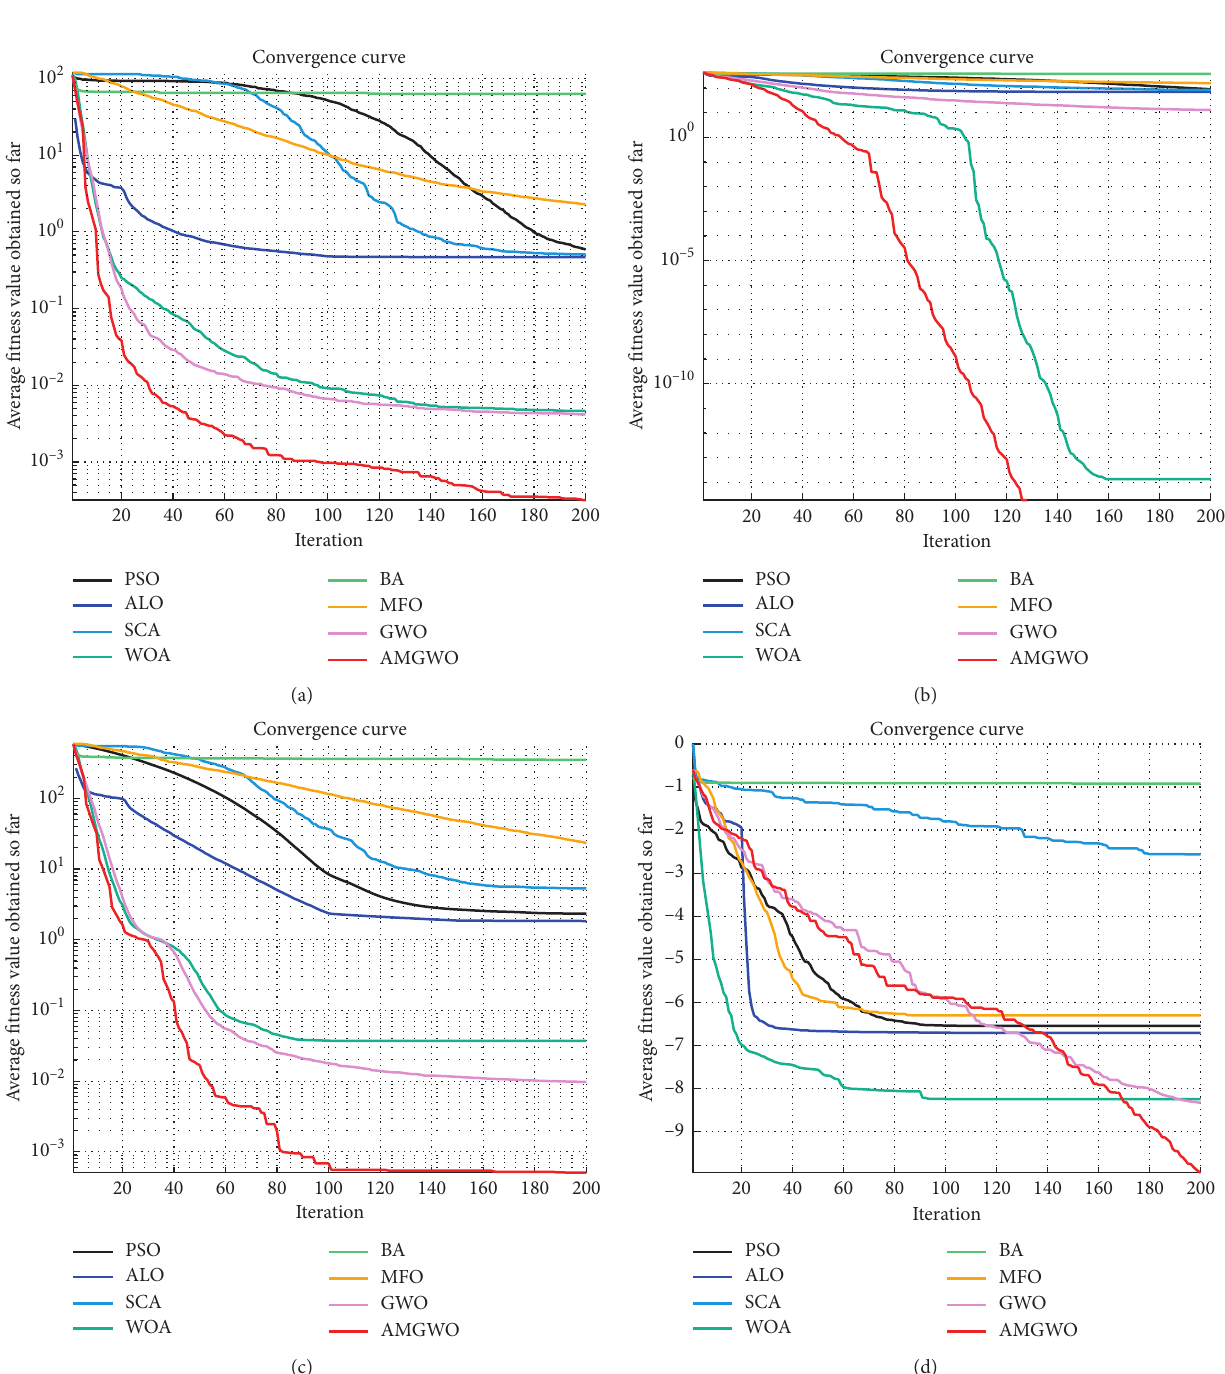
Figure 3: Convergence curves of PSO, ALO, SCA, WOA, BA, MFO, GWO, and the proposed AMGWO on different functions: (a) F (c) F 11 , and (d) F 21